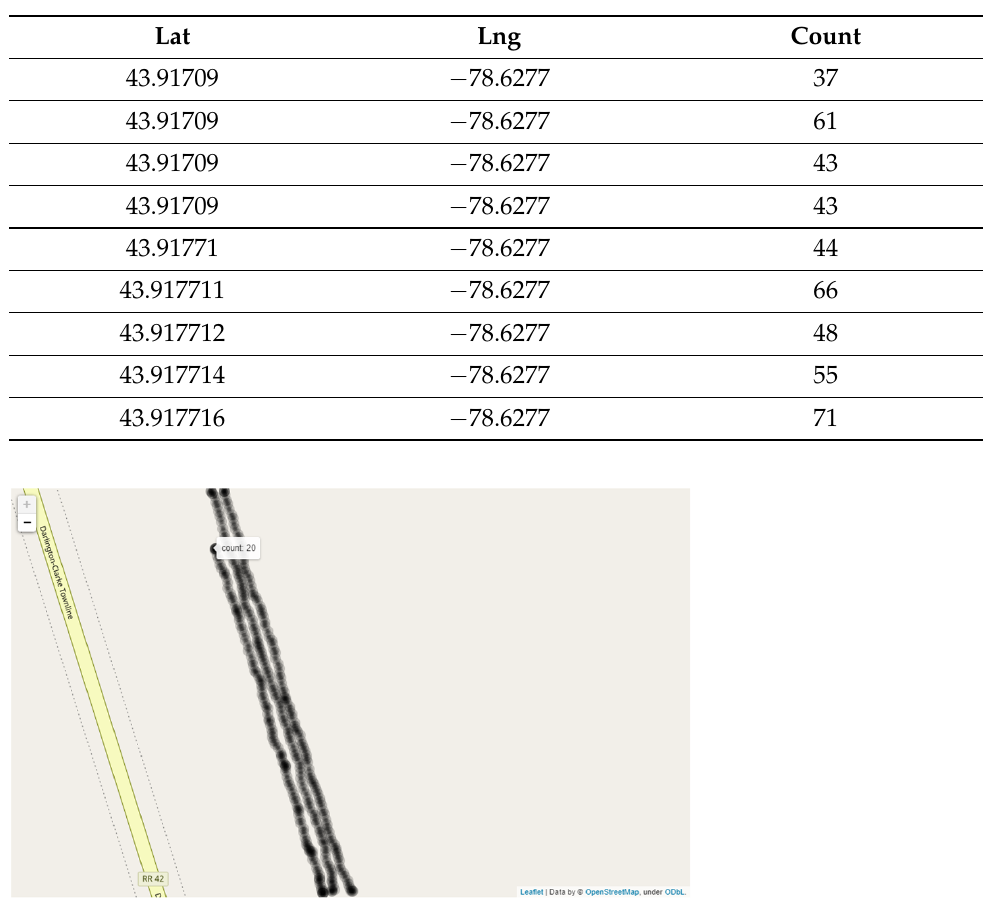
Table 3. A sample from the GPS data in an excel sheet after counting.